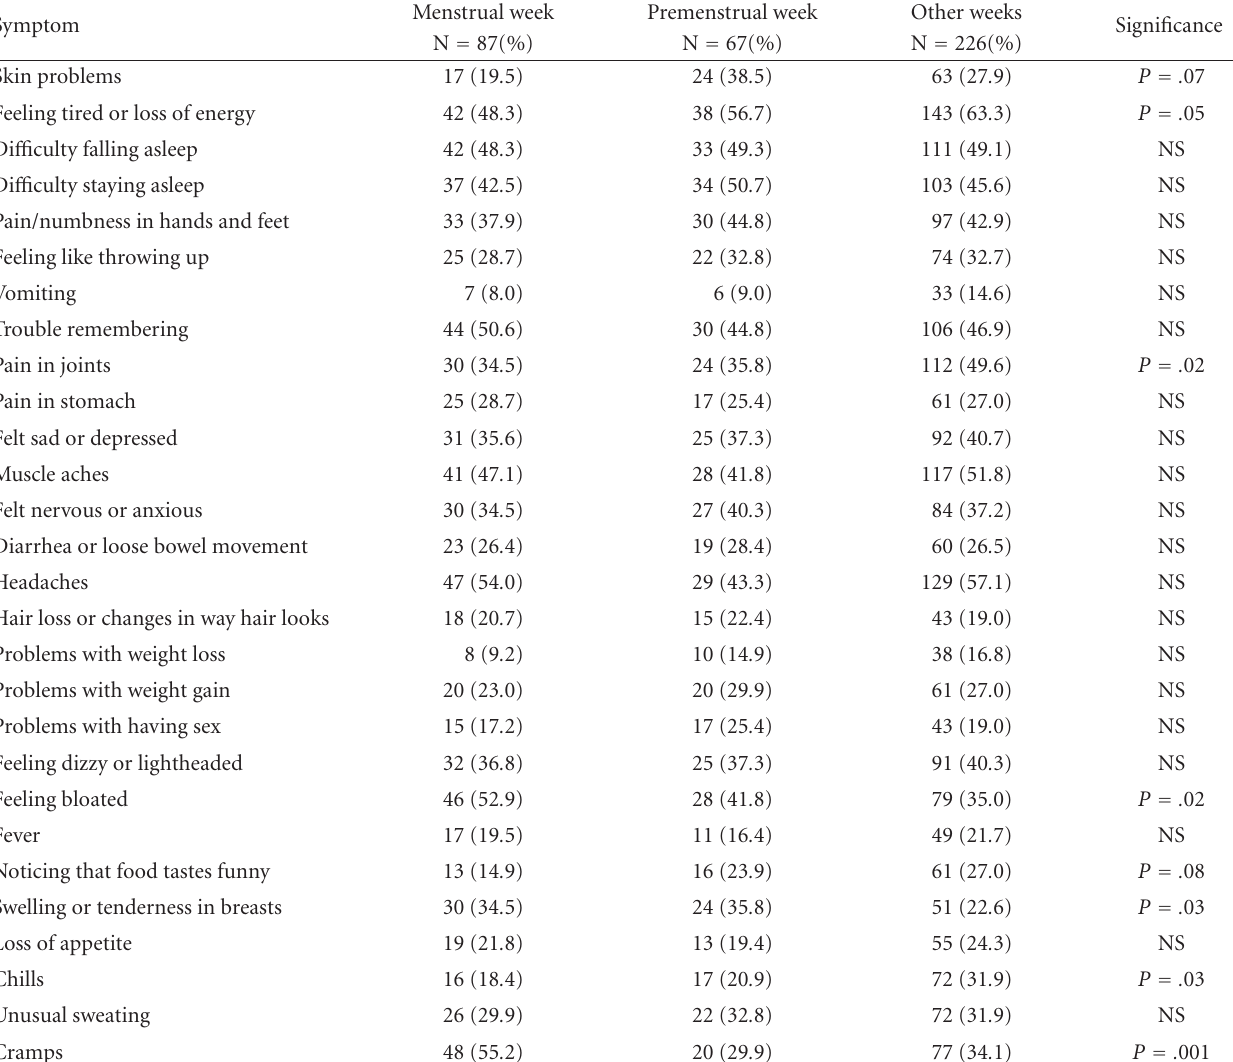
Table 1: Frequency of symptoms by cycle phase among 54 study patients. NS = not